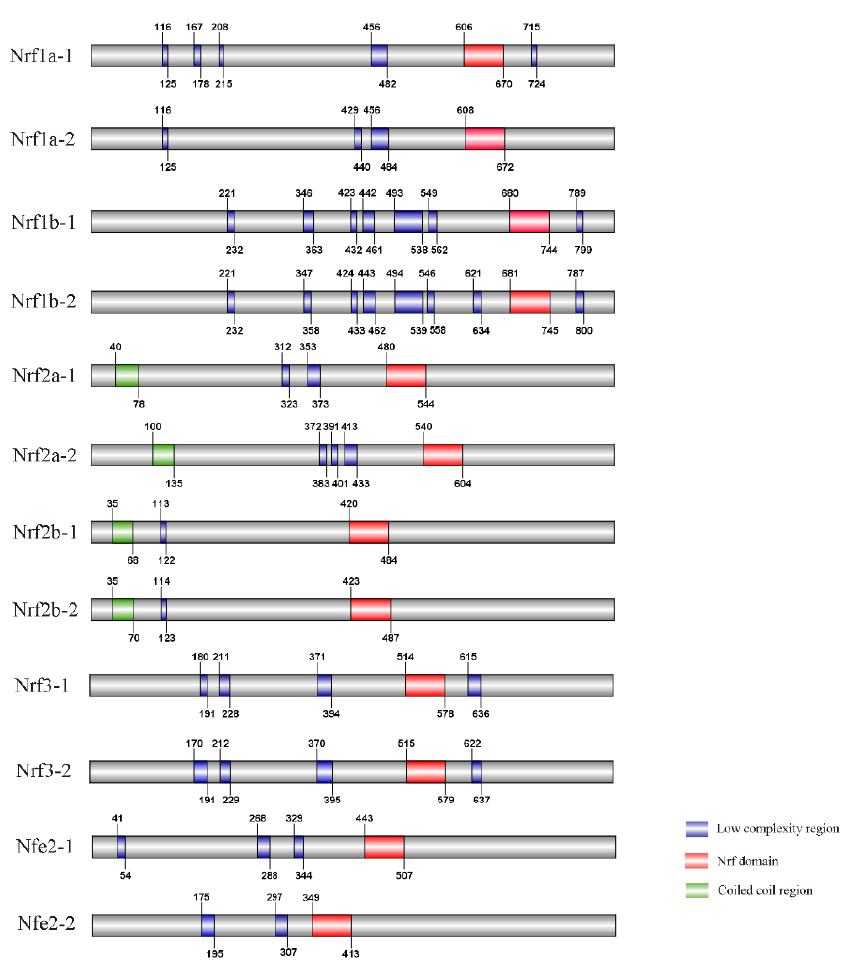
Figure 1. Schematic representation of the Nrf gene domain architecture in common carp.